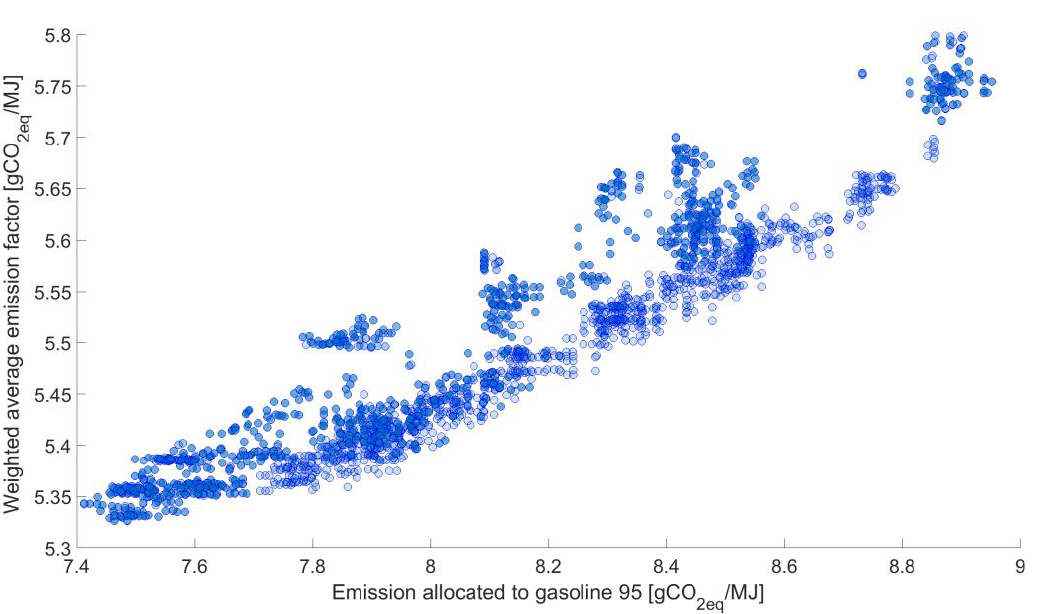
Figure 8. Average GHG emissions versus emissions allocated to gasoline 95.